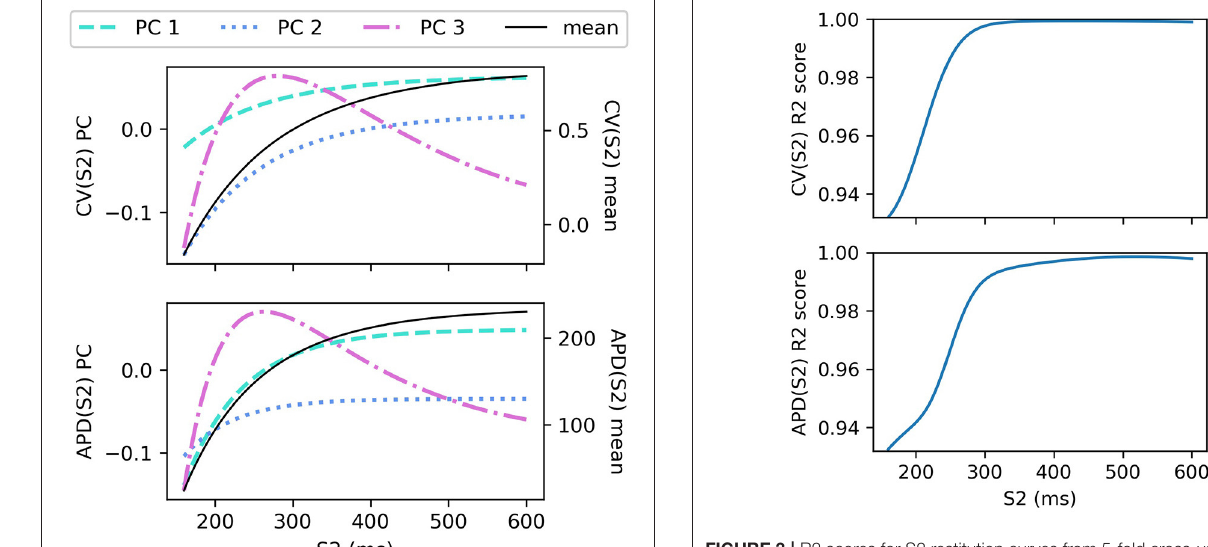
: 68.690, 29.131, 2.148%), so